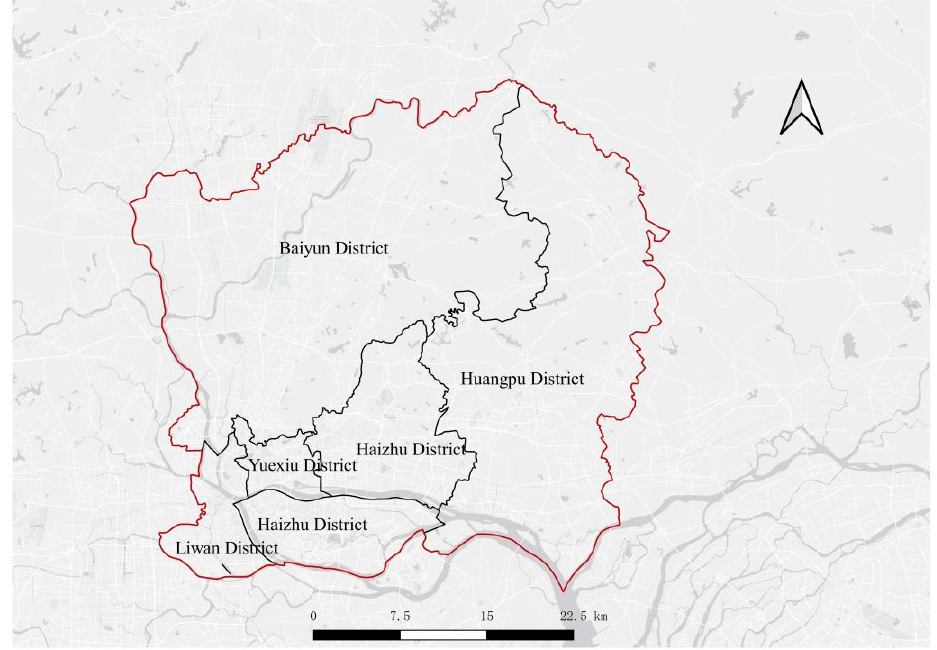
Figure 2. A study area on the informal settlements’ source, drawn by the authors. The background image is from ESRI.